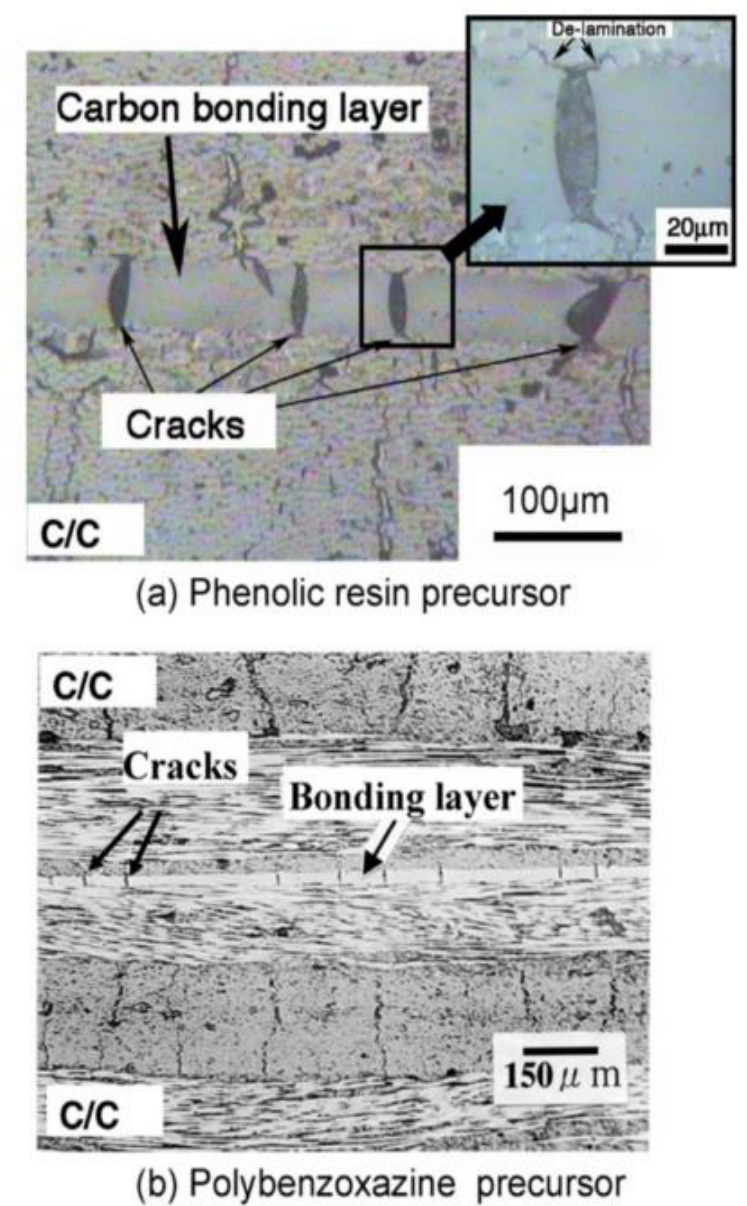
Figure 56. Optical photomicrographs of bonding layer cross sections derived from phenolic resin hot-pressed at 1 MPa during carbonization ( a ) and polybenzoxazine at 10 MPa ( b ) (reproduced from the work in [128] with permission).